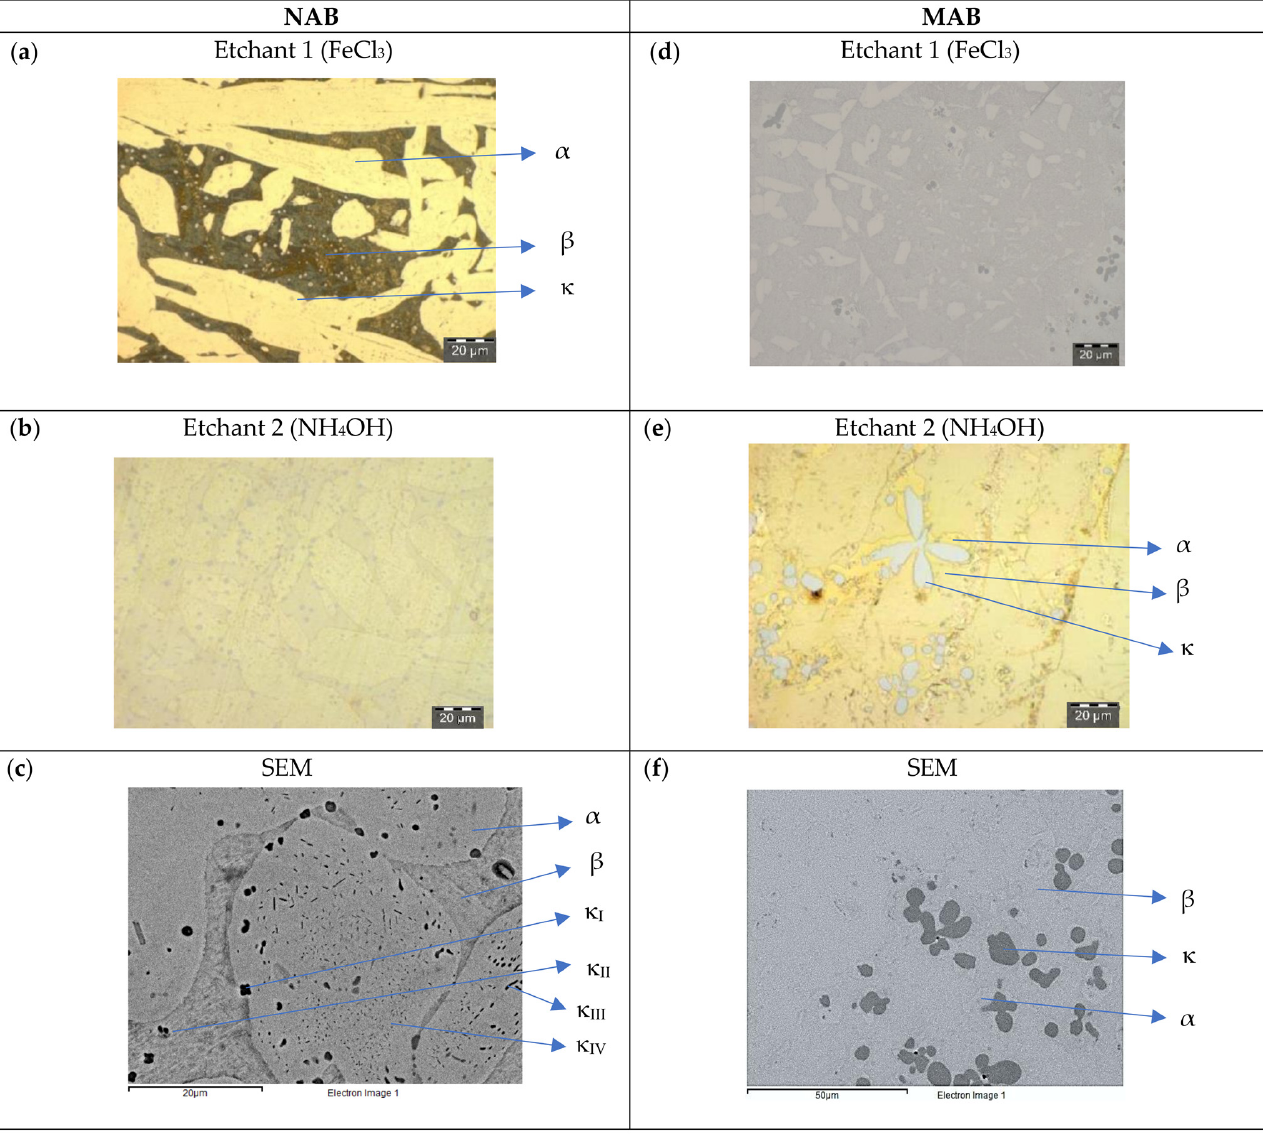
Figure 5. NAB and MAB microstructure after quenching (T1). LOM images after applying etchants 1 ( a , d ) and 2 ( b , e ), and SEM-BSE pictures ( c , f ). Quenched and tempered (T2):